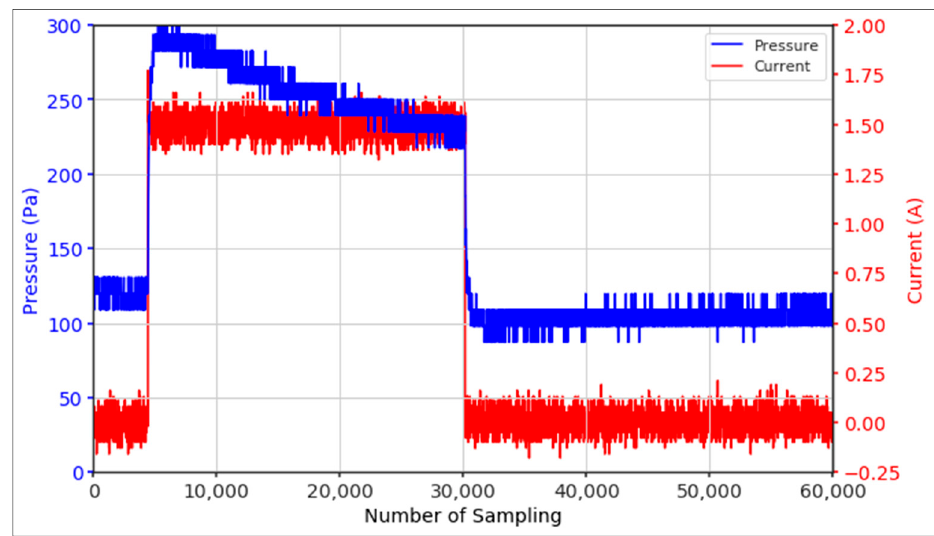
Figure 5. Pressure curve of the application of a magnetic field on for 30 s and off for 30 s.